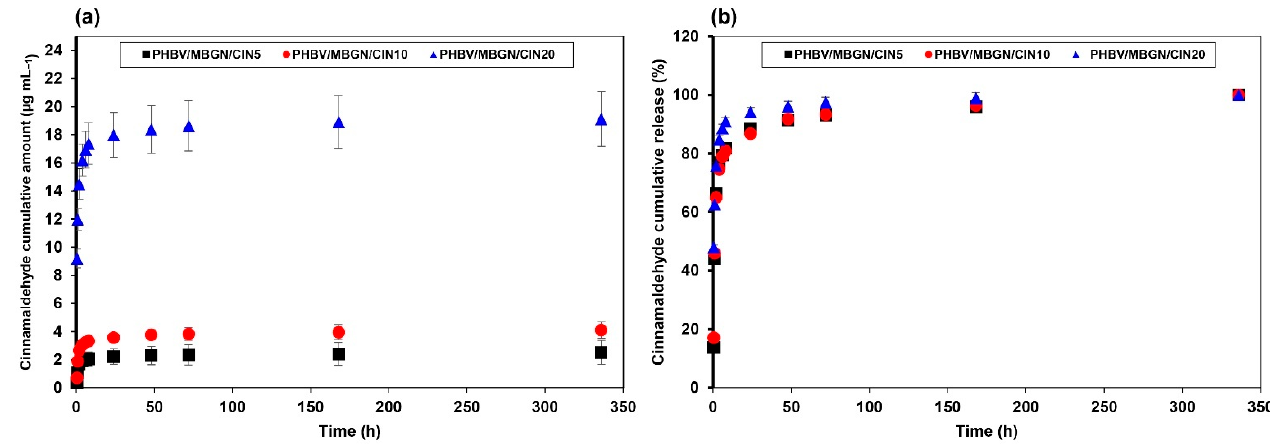
Figure 3. In vitro CIN release behavior of PHBV/MBGN/CIN5, PHBV/MBGN/CIN10, and PHBV/MBGN/CIN20 microspheres in simulated body fluid: ( a ) CIN cumulative amount (µg mL − 1 ), and ( b ) CIN cumulative release (%). Experimental data are reported as mean ± standard deviation. n = 3. A sample of PHBV/MBGN/CIN20 showed the highest CIN cumulative amount and CIN cumulative release. Table 2. Mathematical kinetic models applied to in vitro CIN cumulative release (%) of PHBV/MBGN/CIN5,